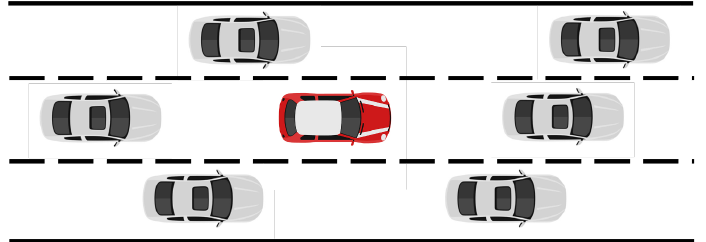
Figure 1. Autonomous Highway Driving problem. The Ego vehicle, i.e., the red one, has to au- tonomously take a safe driving decision, e.g., lane keeping or changing, for traveling in a three-lane highway scenario in the presence of other surrounding vehicles, i.e., the grey ones.